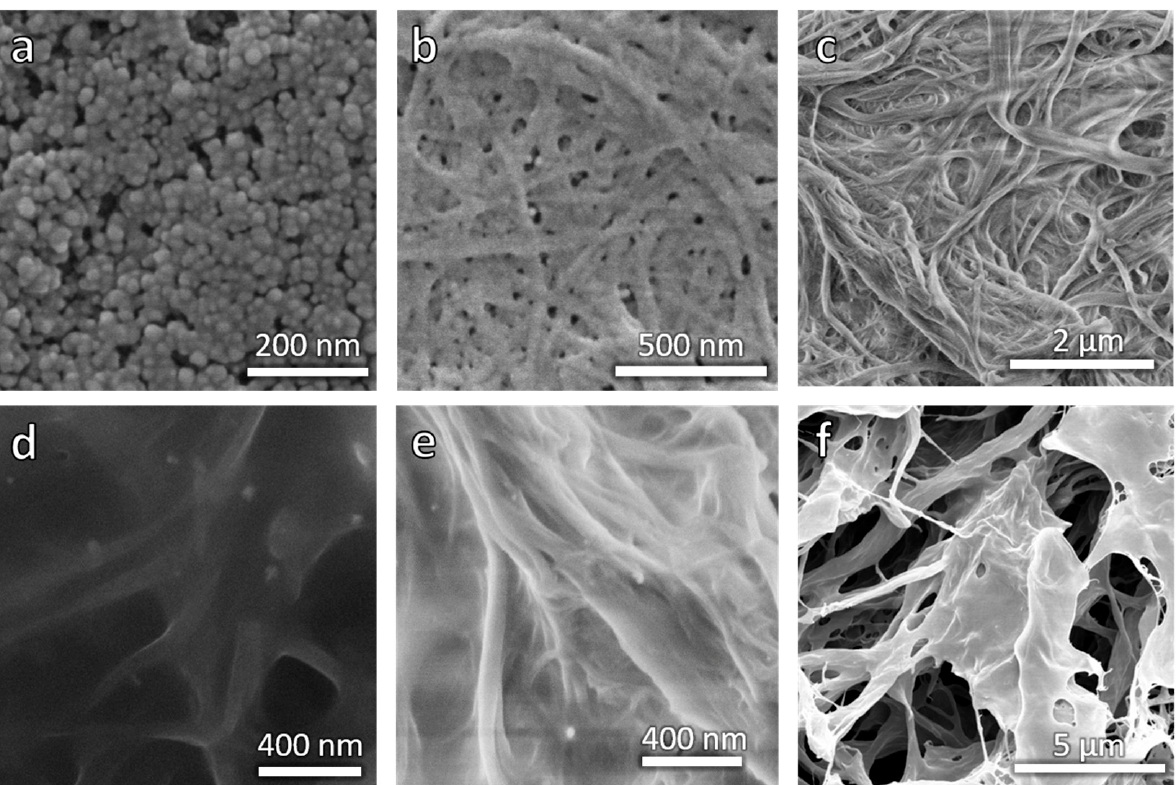
Figure 4. SEM pictures of samples. ( a ) CFO, ( b ) CNF-MI, ( c ) CNF–PSA–CFO, ( d ) CNF–PSA–CFO, ( e ) CNF–PSA–CFO, and ( f ) CNF–PSA–CFO 3D printed, freeze-dried, and cut open. Pictures d and e were taken with the EsB